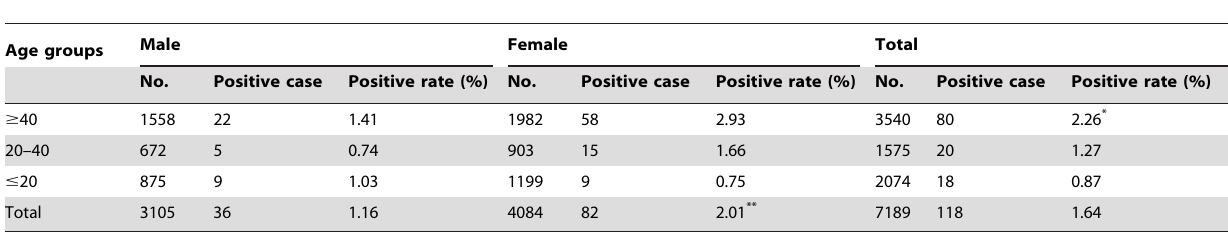
Table 2. Anti-HCV positive rate of different gender and age